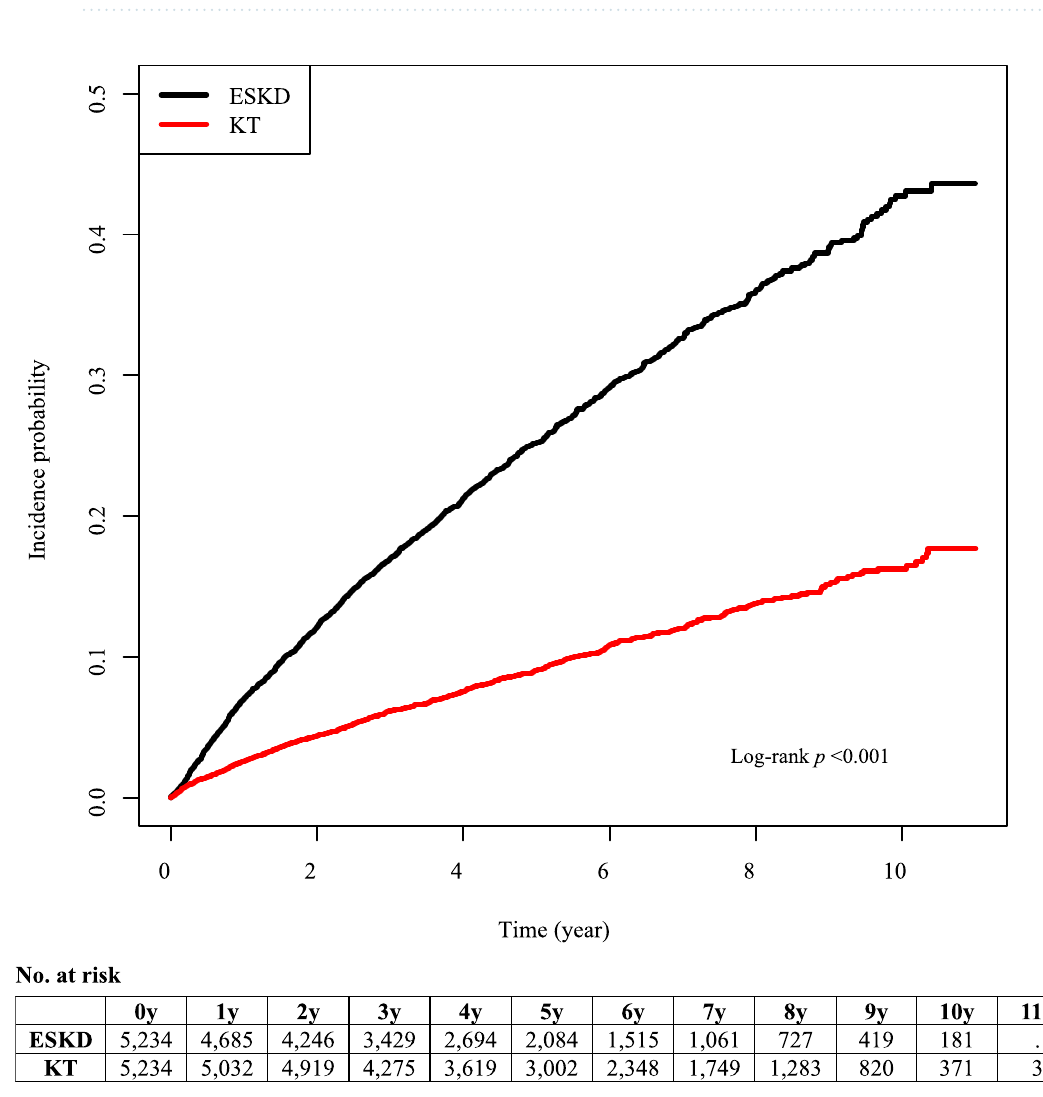
Table 3. Incidence rate and risk of depression in ESKD, KT and HC groups. *IR: incidence rate per 1000 person-years. **Model 1 was adjusted for age and sex. ***Model 2 was adjusted for age, sex, presence of hypertension, diabetes mellitus and dyslipidemia, and CCI score. ESKD end-stage kidney disease, KT kidney transplantation, HC healthy control.